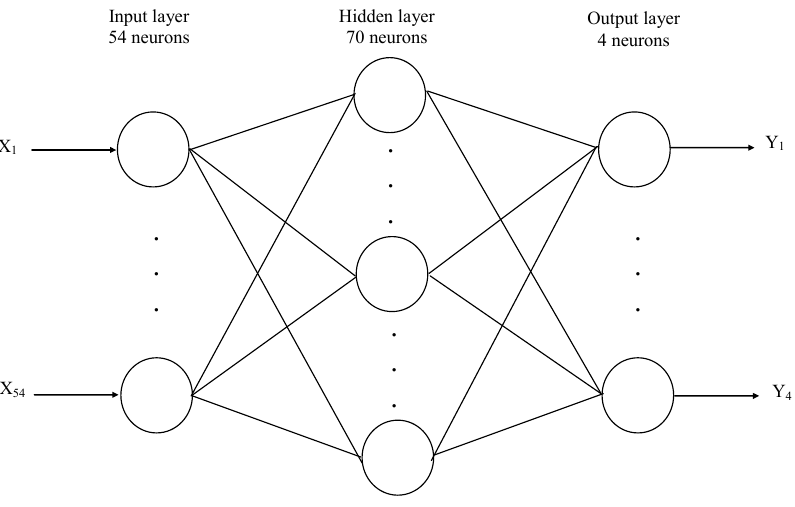
Figure 6. Structure of the optimal ANN. Table 9. (R)MSE values for three MLP neural